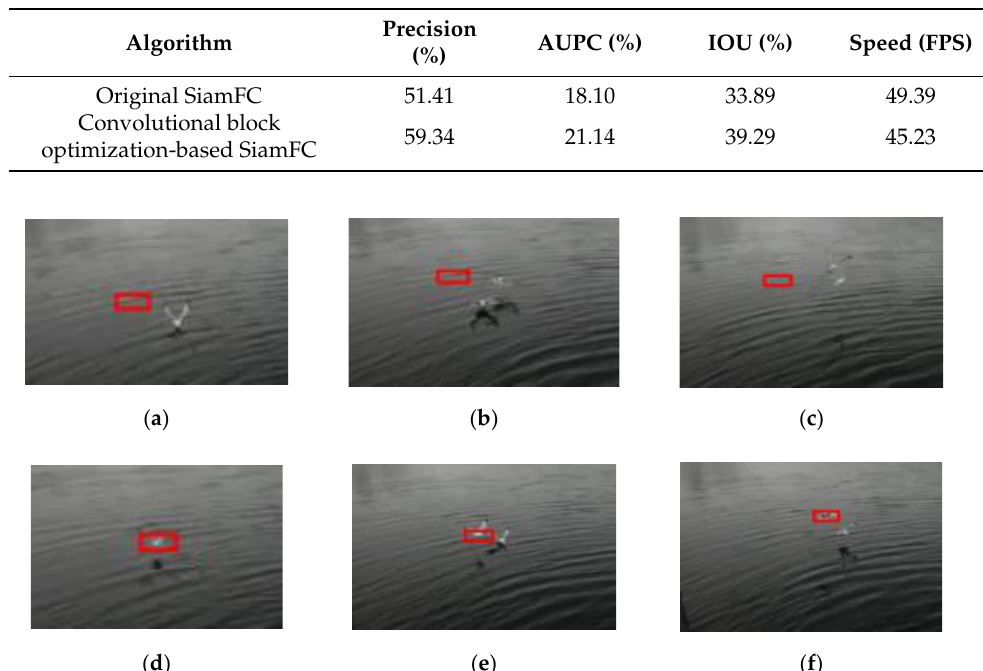
Table 4. Overall results comparison of convolutional block optimization-based SiamFC with origi- nal SiamFC.